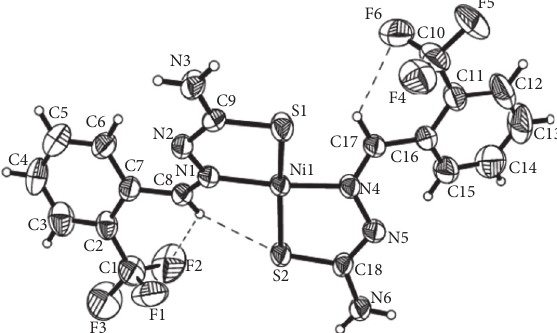
Figure 2: Molecular structure of NiL